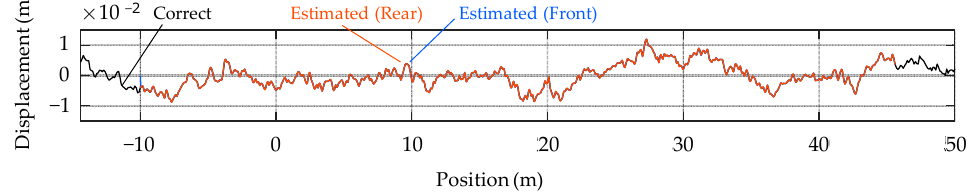
Position (m) ( 600 ) minimizing J in Scenario best